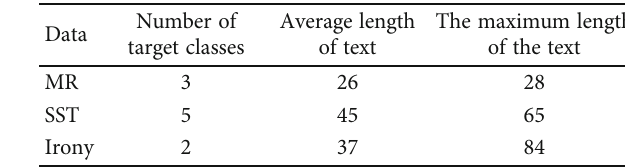
Table 1: Details of data sets of di ff erent